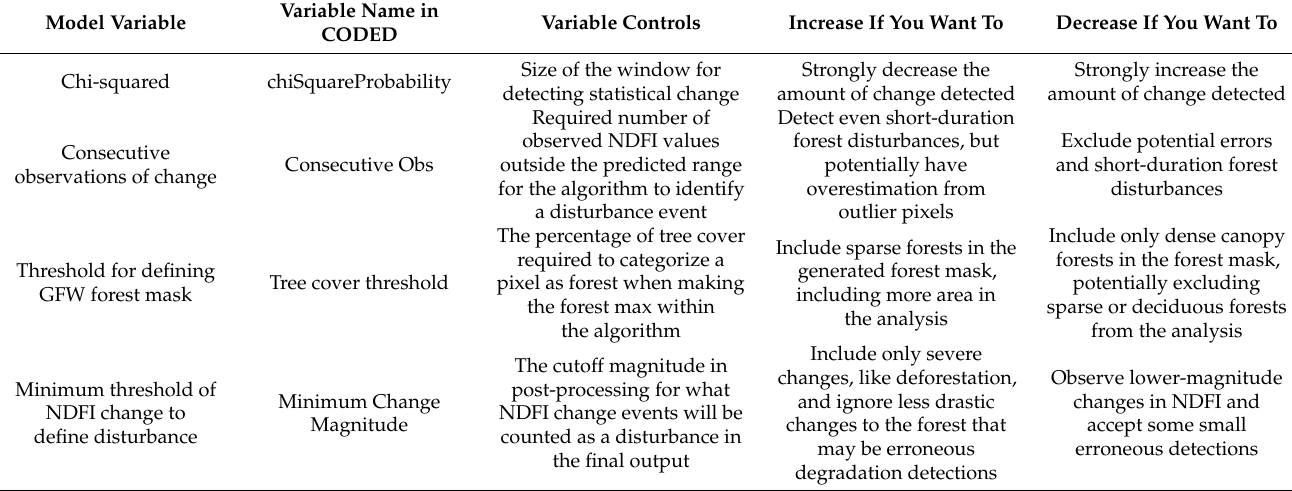
Figure 4. Thumbnail images showing the effects of changes to three parameters. ( a ) The location of the region for the thumbnail images is in the southeastern Terai region, and a color key for maps in the figure. ( b ) Thumbnail images of the region of interest, with Landsat data from 2010 and 2020 displayed as infrared composite imagery. ( c ) Comparison of different forest masks: two forest canopy thresholds using the GFW forest mask and the NLCMS forest mask. ( d ) Comparison of different numbers of consecutive observations. ( e ) Comparison of different values of chi-squared. ( f ) Comparison of different NDFI change magnitude thresholds, a post-processing parameter. Aside from the parameter indicated below each image, all parameters used to create it are the same as those selected in iteration 11. Table 3. Change implications associated with CODED variables determined to be especially impactful on deforestation and degradation